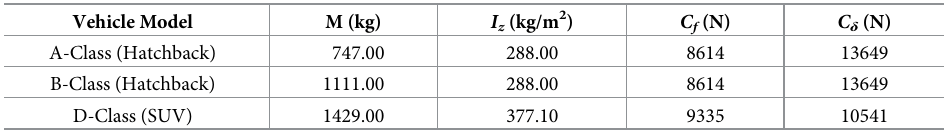
Table 1. Vehicle model parameter settings in CarSim.